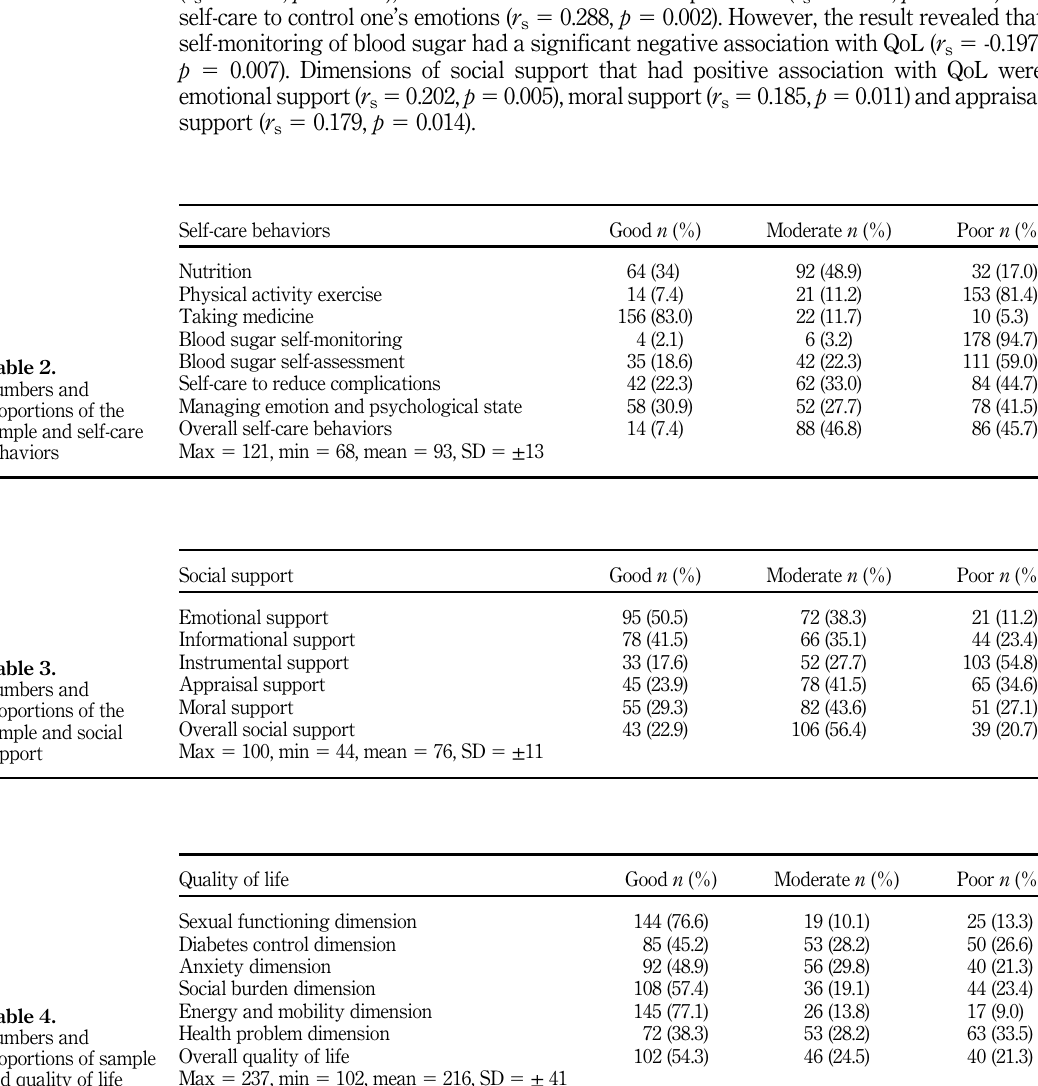
proportions of sample and quality of